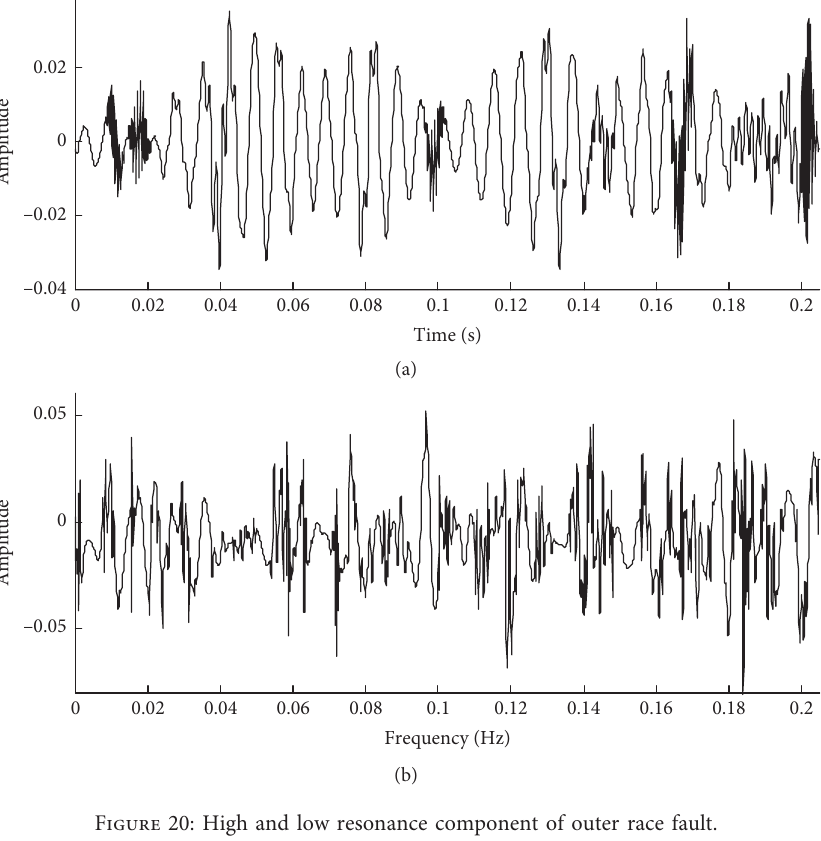
Figure 20: High and low resonance component of outer race fault.